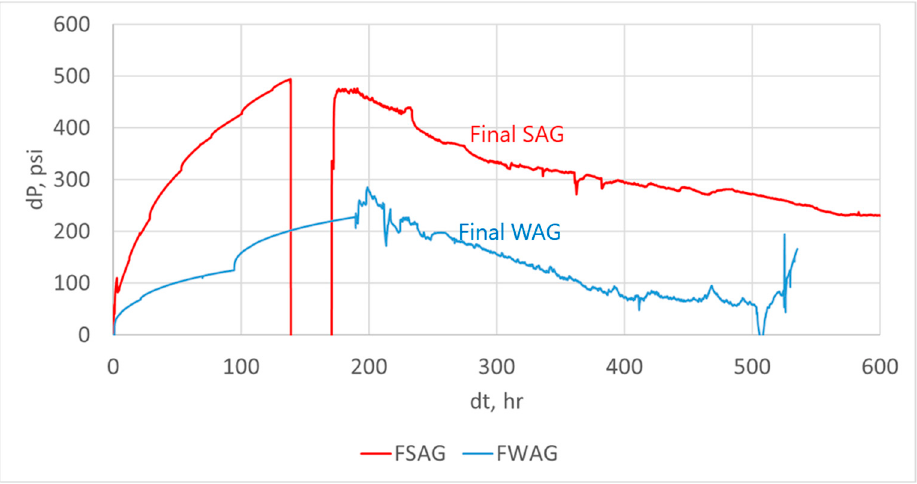
Figure 9. Transient bottom-hole pressure (dP) versus injection time (dt) for the final SAG cycle (red curve) and for the WAG cycle (blue curve).